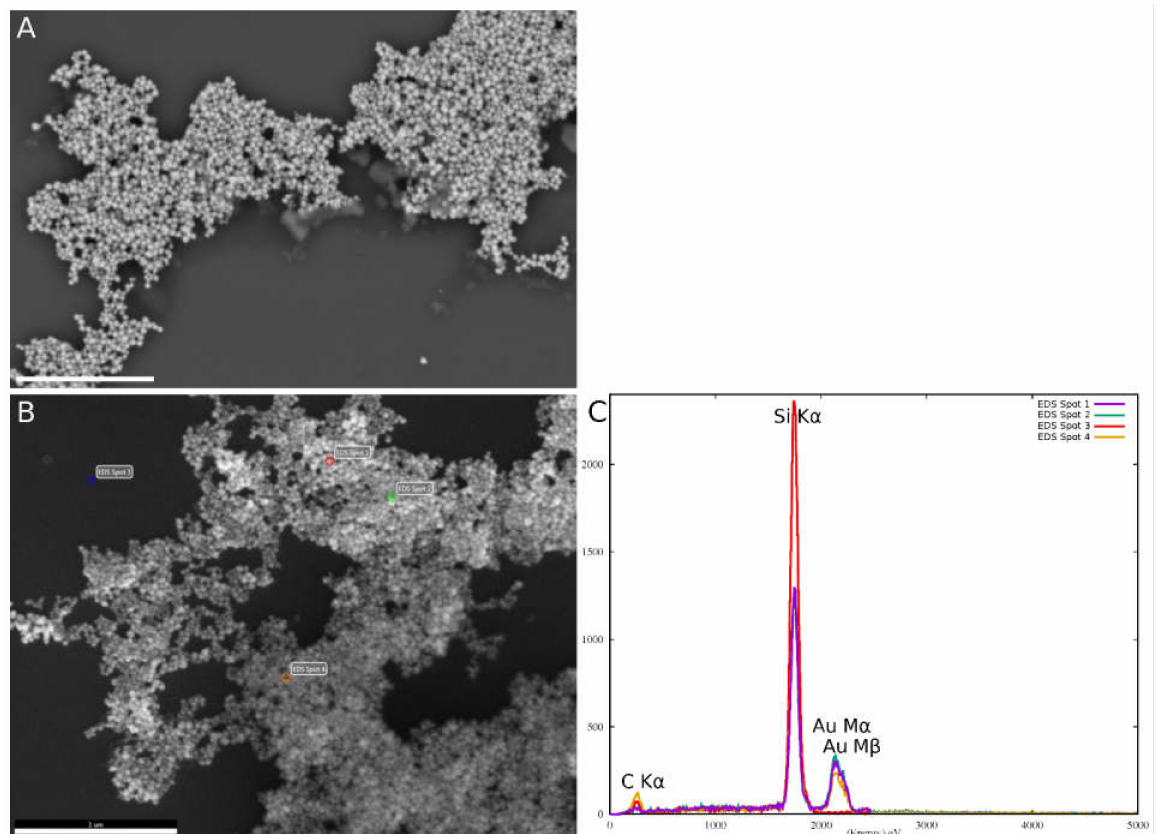
Figure 13. SEM and EDS images obtained from different samples: ( A , B ) SEM results of the washed sample at pH 10; ( C ) EDS results of the washed sample at pH 10. The samples were placed on glow-discharge-activated silicon